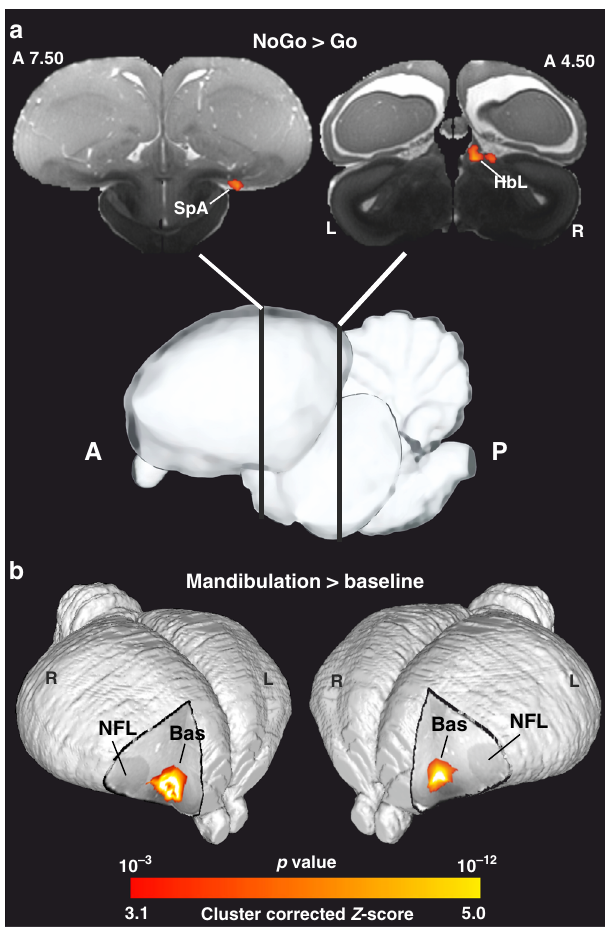
Fig. 4 Inhibitory and mandibulation response patterns. a Statistical activation maps for signal increase in the contrast of NoGo > Go ( Z = 3.1 and p < 0.05 FWE corrected at the cluster level, group analysis). b 3D representation of statistical activation map for signal increase from the contrast of mandibulation > rest ( Z = 3.1 and p < 0.05 FWE corrected at the cluster level, group analysis). The activation maps were registered and illustrated on the pigeon atlas. The activation signi fi cance is demonstrated by the color scale. HbL lateral habenula, SpA subpallialis amygdalae, Bas nucleus basalis, NFL nidopallium